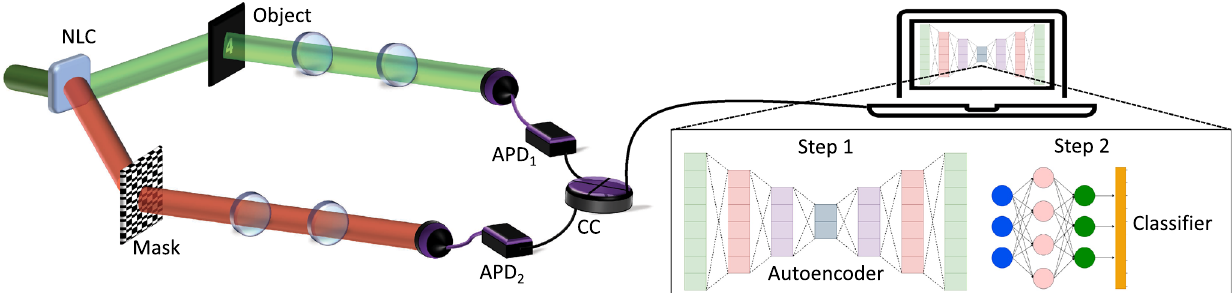
Figure 1. Conceptual sketch of an all-digital ghost imaging setup powered by a two-step deep learning approach. Non-degenerate entangled photons are spatially separated along two arms. One photon interacts with the object and is collected by a bucket detector. The other photon is collected by a spatially resolving detector comprising a patterned mask and a bucket detector. Each detector is connected to a coincidence counting device to perform coincidence measurements. The image is reconstructed by a linear combination of the patterned masks weighted by the coincidences. The reconstructed image, after each measurement, is passed through both the deep learning algorithms for image enhancement and